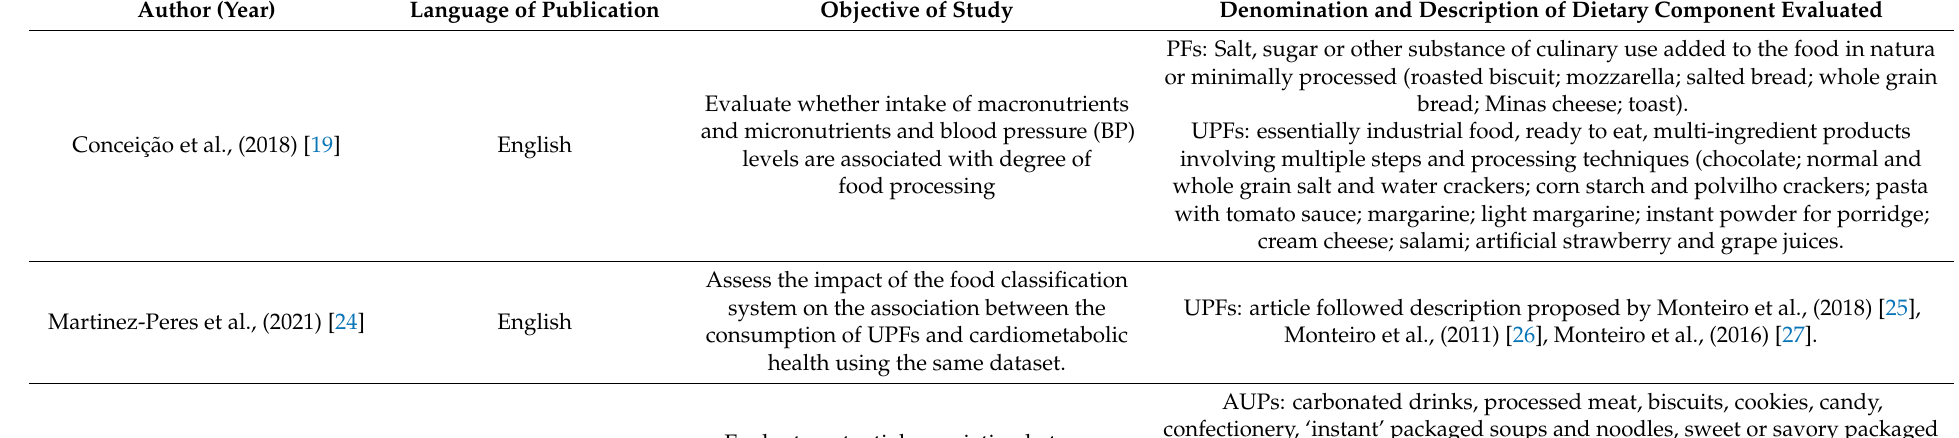
Table 1. Overview of studies selected for present review ( n =